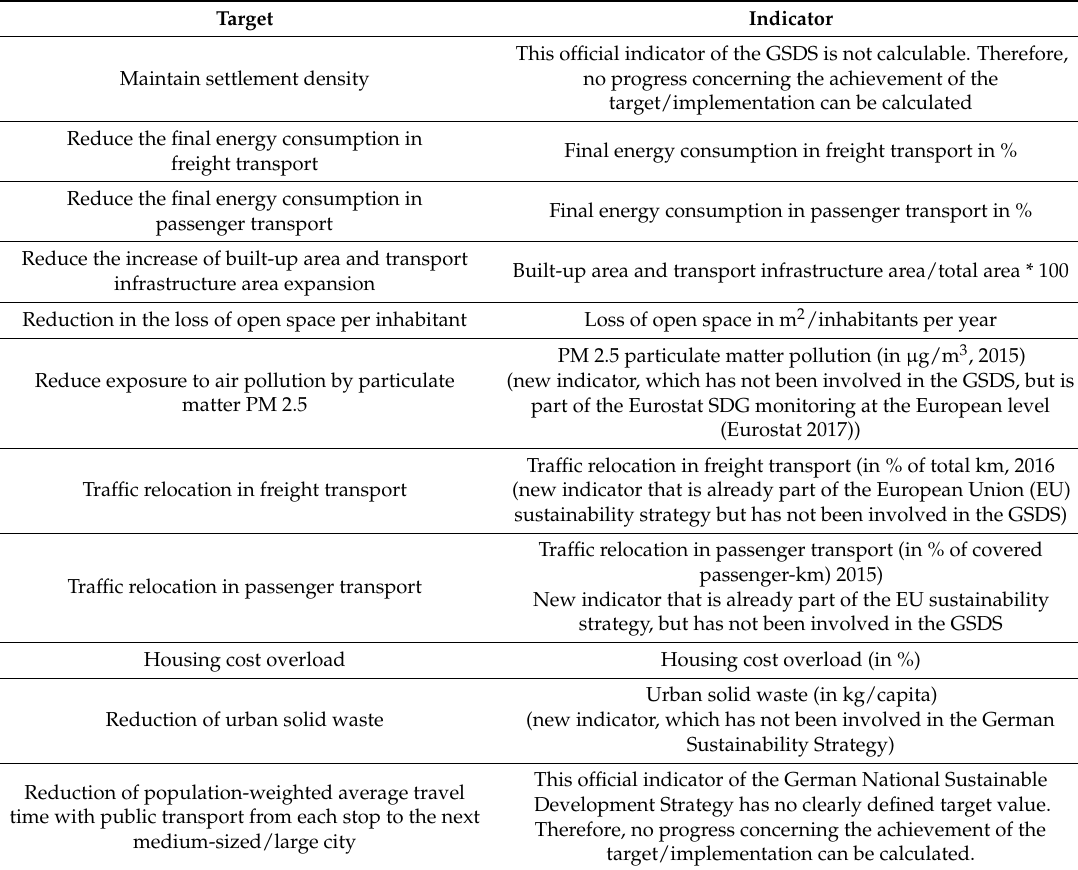
Table 3. Targets and Indicators of Goal 11 developed by